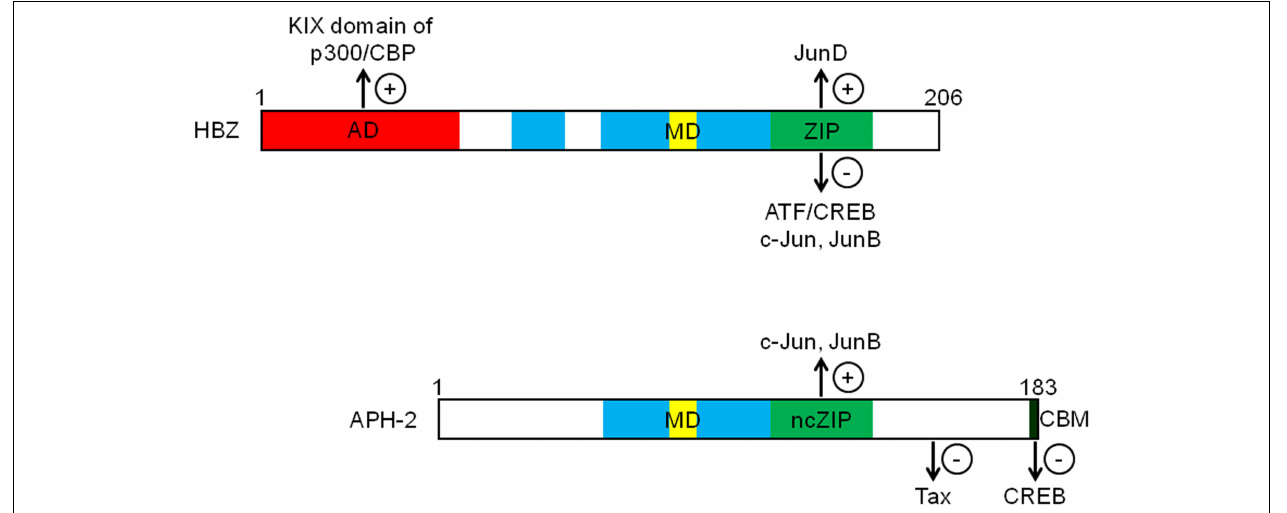
contain any activation domain, it can interact with c-Jun and JunB through a non-canonical ZIP region (ncZIP in green) and with CREB through a C-terminal CREB-binding motif (CBM in black). Unlike HBZ, APH-2 binds toTax ( + ) and ( − ) respectively indicate an activating or inhibiting effect of viral proteins on targeted